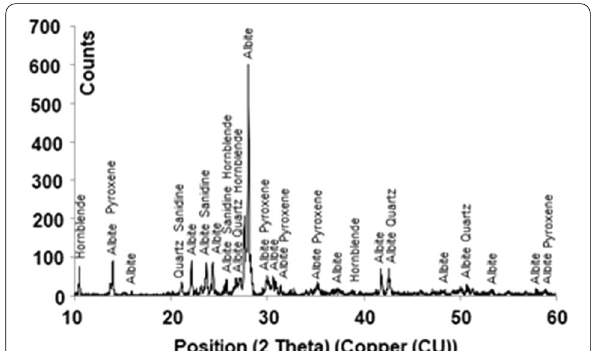
Fig. 3 XRD pattern of the raw trachyte